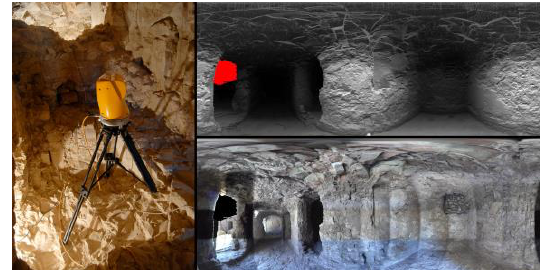
Figure 1. Left: the scanner at work. Top right: a panoramic view of one of the scans points cloud. Bottom right: a panoramic image of the same